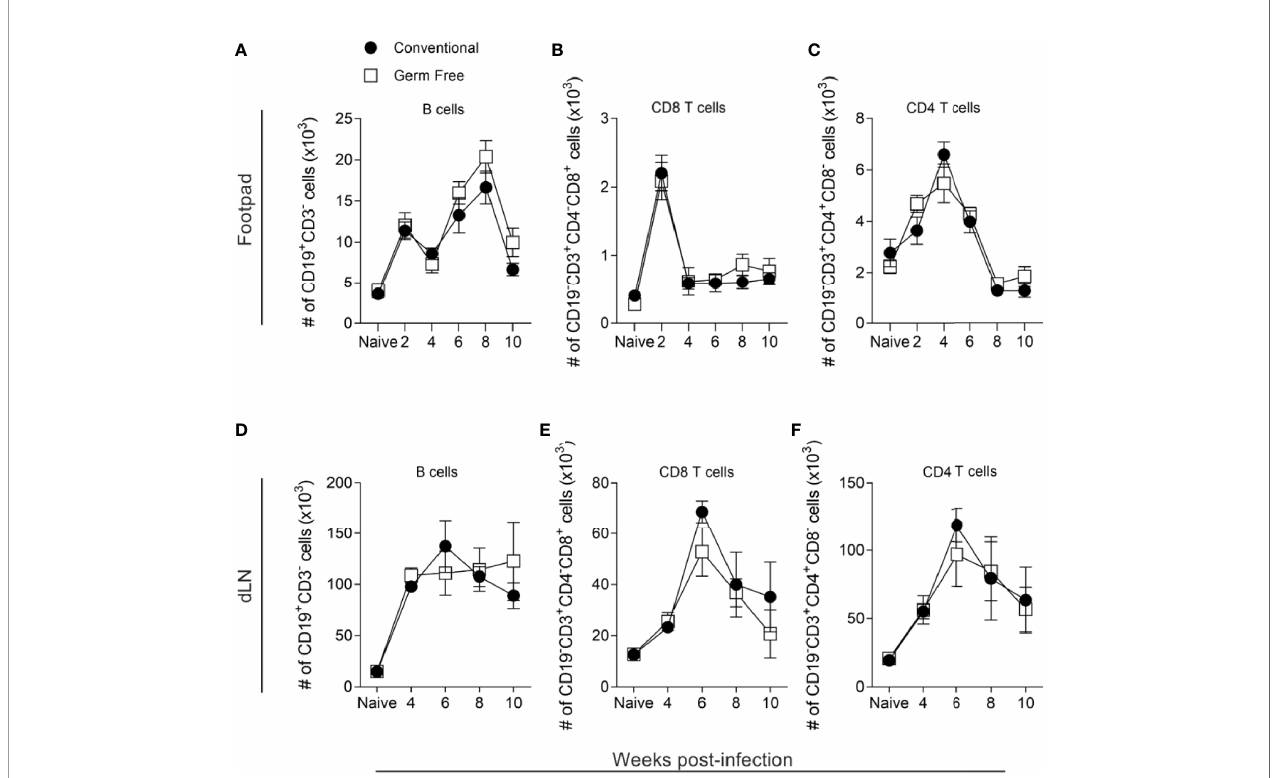
FIGURE 2 | Host microbiota did not alter lymphocyte in fi ltrates in lesions or draining lymph nodes. (A – C) Absolute number (#) of lymphocytes in the footpads of uninfected and infected mice, 2-10 weeks after infection. (D – F) Absolute number (#) of lymphocytes in the popliteal lymph nodes (dLN) of uninfected and infected mice, 4-10 weeks after infection. Groups of mice were compared at the same time point using two-way ANOVA and Bonferroni post-test (p < 0.05). Results are representative of two independent experiments. Four to 6 animals per group were used per